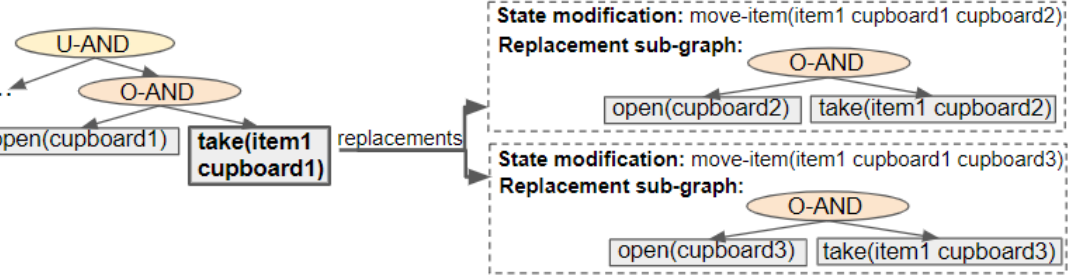
Figure 9. Example of an action currently in the Action Graph, i.e., take(item1 cupboard1) , which can be affected by 2 state modification actions. Thus, it can be replaced, by swapping its parent ORDERED-AND node with one of its replacement